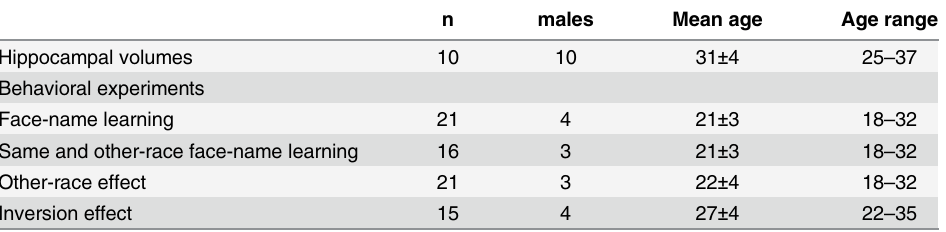
Table 1. Demographic details for control samples tested for the four tests of face processing and comparison of the hippocampal